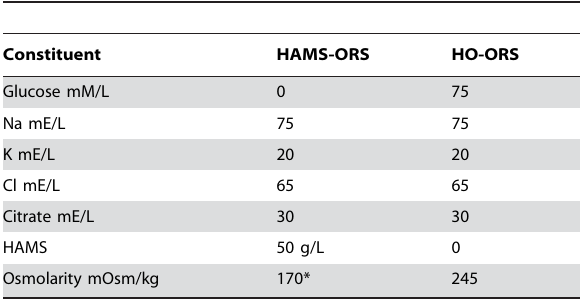
Table 1. Composition of the two oral rehydration solutions